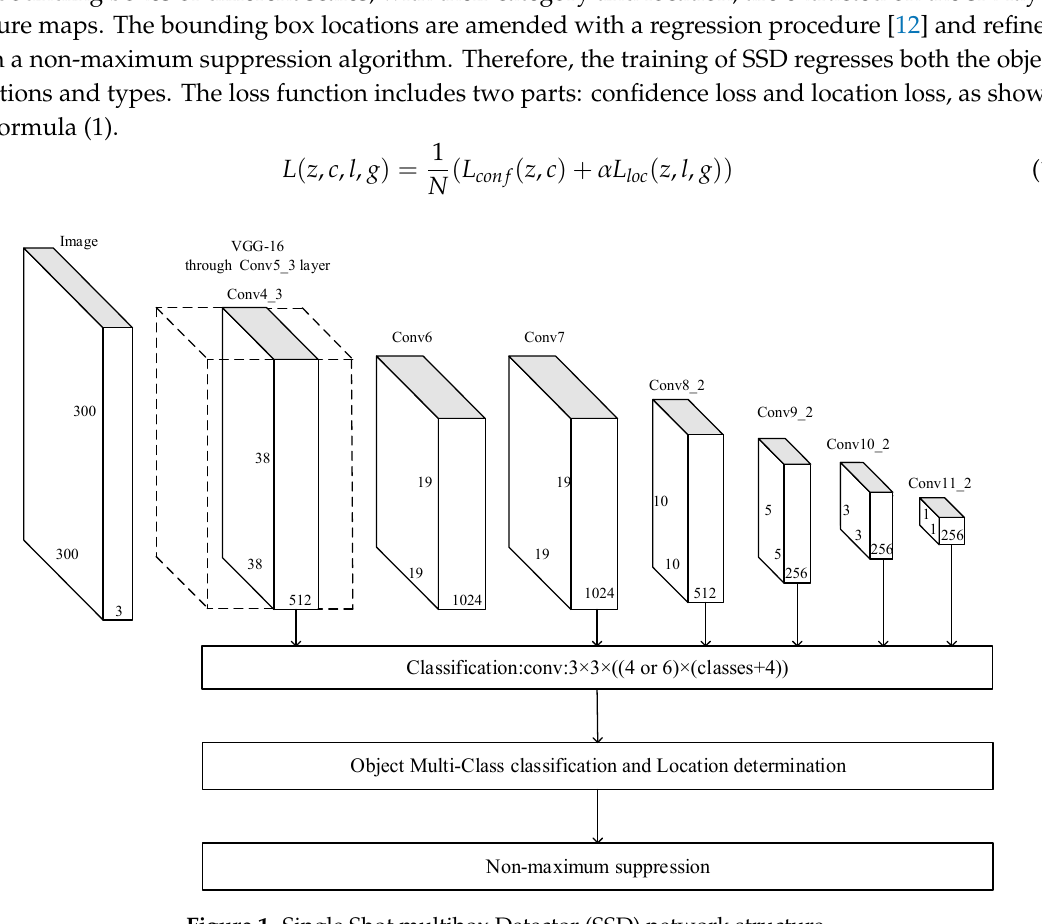
Figure 1. Single Shot multibox Detector (SSD) network structure.